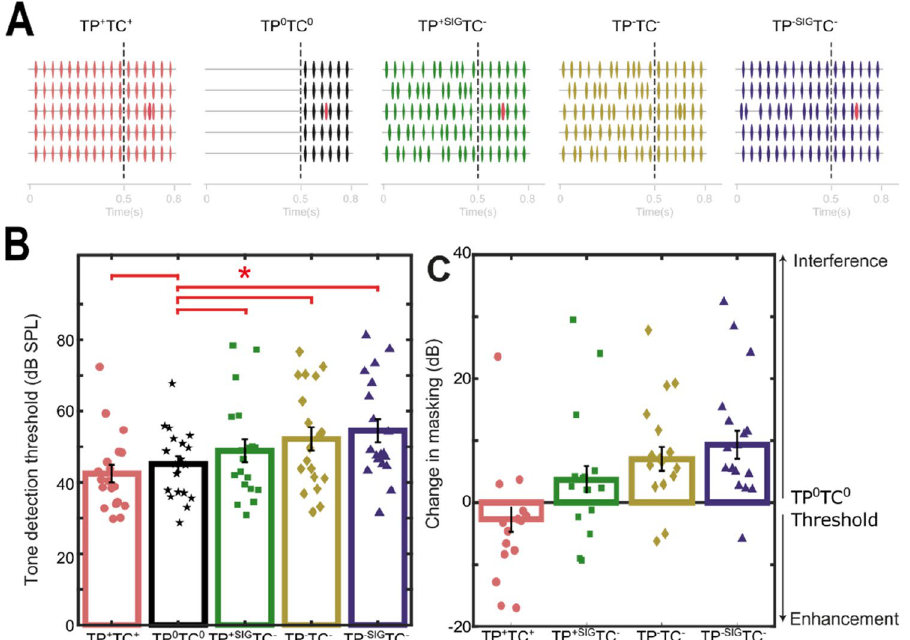
Figure 2. Discontinuity in sound statistics (temporal coherence and/or predictability) causes interference in the grouping process. ( A ) Stimulus schematic. Five conditions were contrasted: a neutral condition (i.e. no build-up: TP 0 TC 0 ) and four where the build-up was varied (i.e. TP + TC + = both temporal coherence and predictability, TP +SIG TC − = Temporal predictability in the signal band only and without temporal coherence, TP − TP − = Unpredictable (jittered) and no temporal coherence and TP −SIG TP − = Temporal predictability and coherence in the flanking bands but a jittered signal band). ( B ) Tone detection thresholds for each condition. Red bars indicate significant differences between the neutral condition and the precursor conditions, identified in Table 2 (for full pairwise comparisons see Table 3) ( C ) The aim of these manipulations was to measure the relative contribution of “enhancement” (decrease in threshold w.r.t. the neutral condition) and “interference” (relative increase in threshold w.r.t. the neutral condition). Temporal predictability and coherence in the build-up tended toward enhancing the tone (though did not reach significance), whereas, jittering the signal band (TP −SIG TC − ) or in all frequency bands (TP − TC − ) produces significant